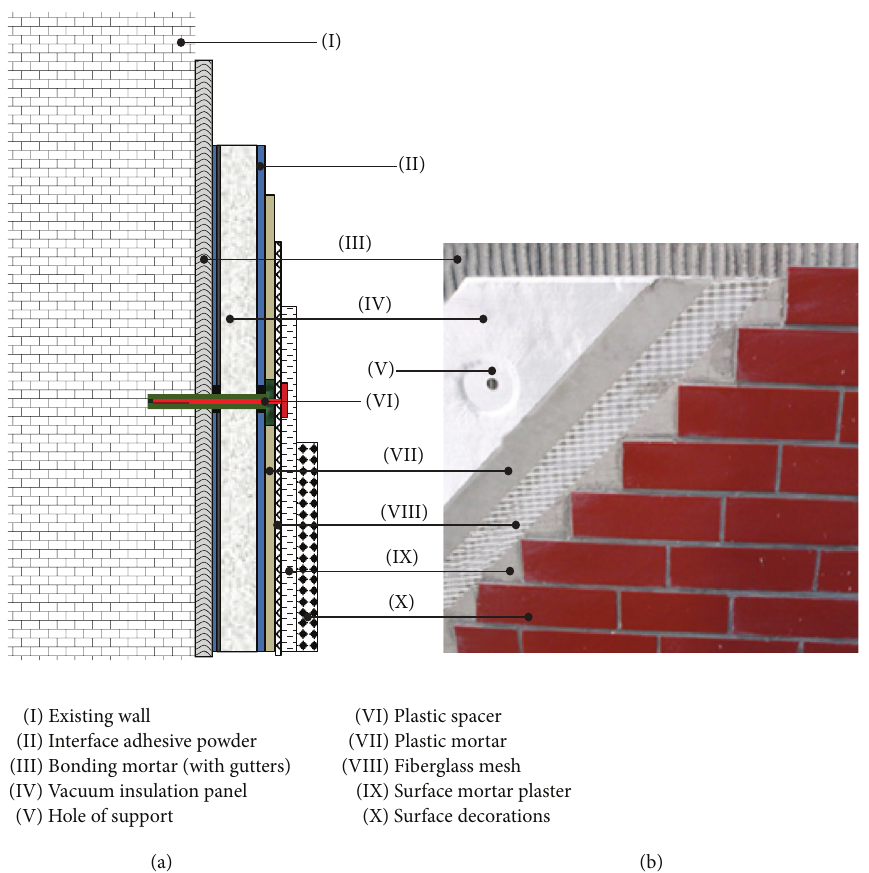
Figure 17: Assembly of vacuum insulation system: (a) cross section and (b) pictorial view of insulated wall [30].